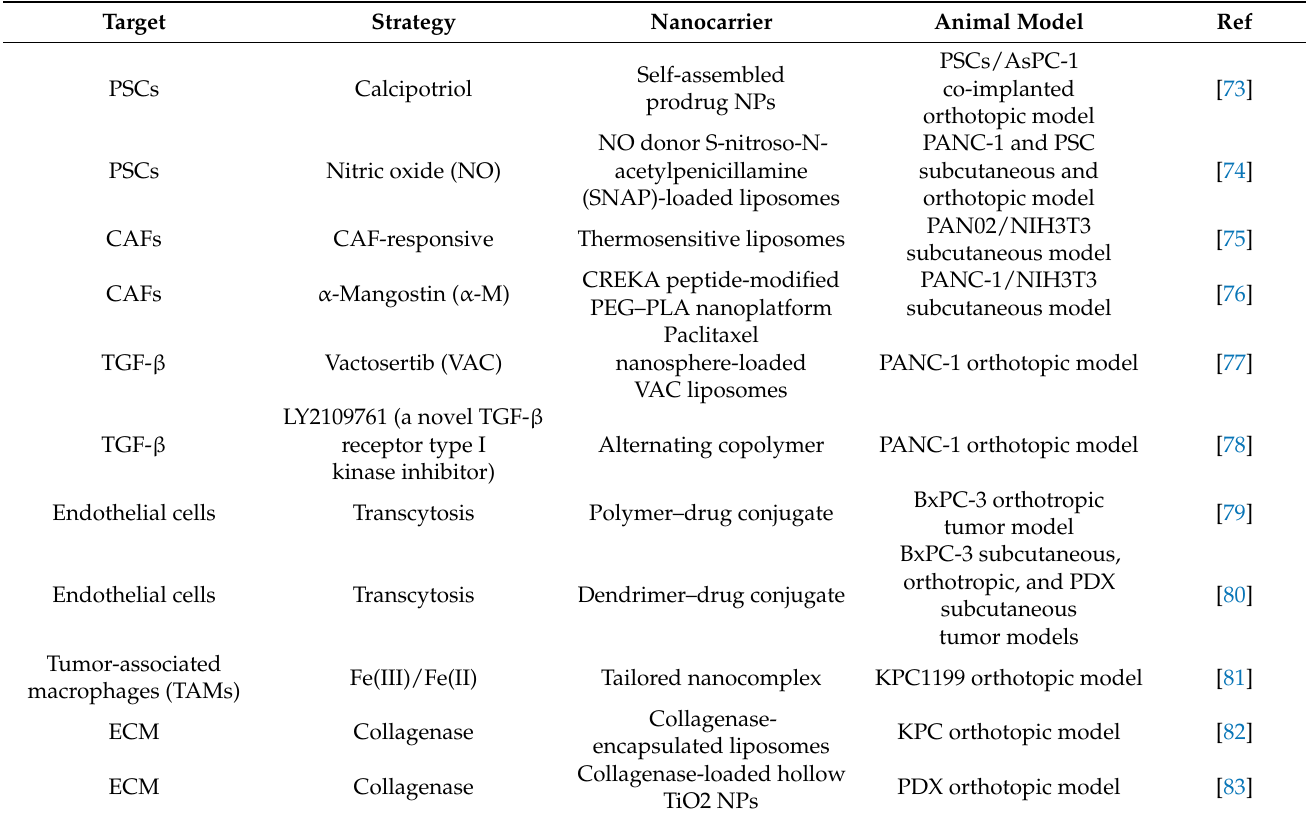
Table 4. Recent advances in nanosystem-mediated modulation of PDAC